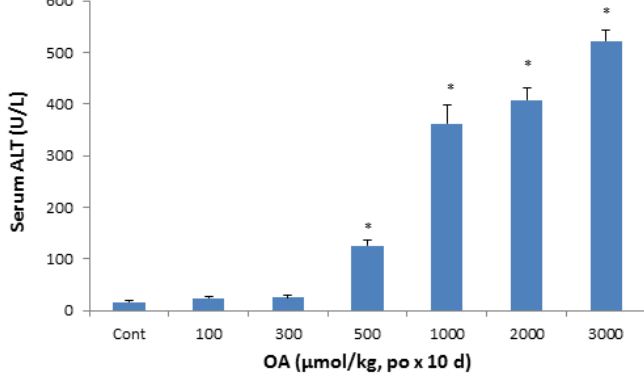
Figure 2. Effect of oral OA on serum biochemistry. Mice were gavaged OA at doses of 100-3,000 µmol/kg (equal to 45-1350 mg/kg), once daily for 10 days. Twenty-four hours after the last dose, blood was collected to determine changes in serum activities of alanine aminotransferase (ALT) and the concentration of total bilirubin as detailed in Methods. Data are mean ± SEM (n = 5–8). * Significantly different from control, p <